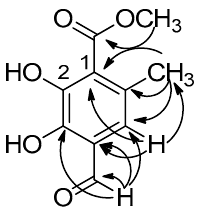
Figure 4. Proton–carbon correlations of methyl 4-formyl-2,3-dihydroxy-6-methylbenzoate 13 .